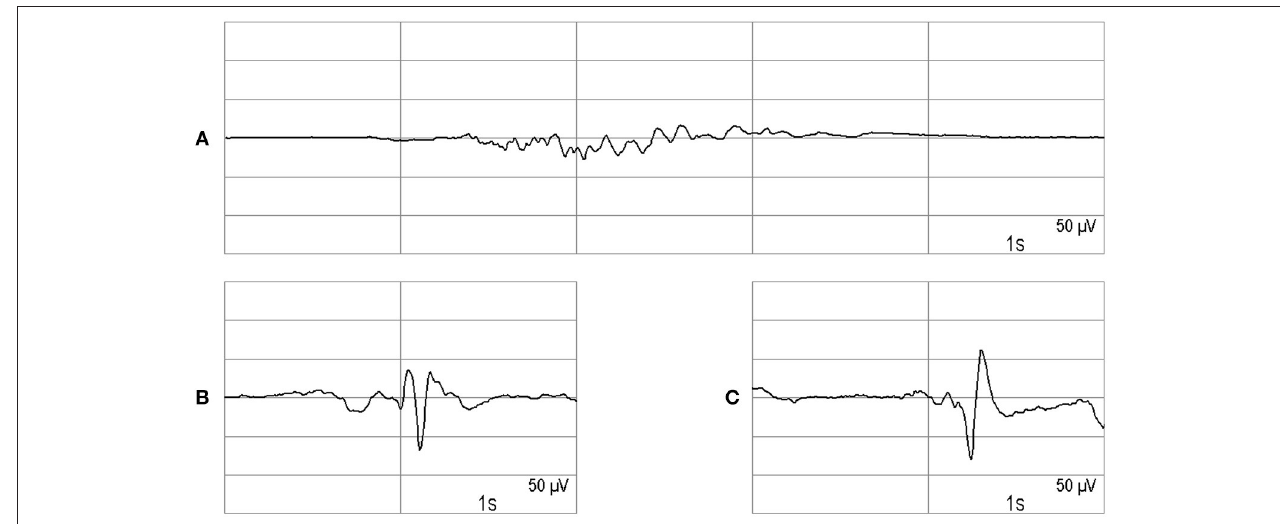
FIGURE 1 | (A) Burst suppression. (B,C) Epileptiform potentials recorded in two patients.